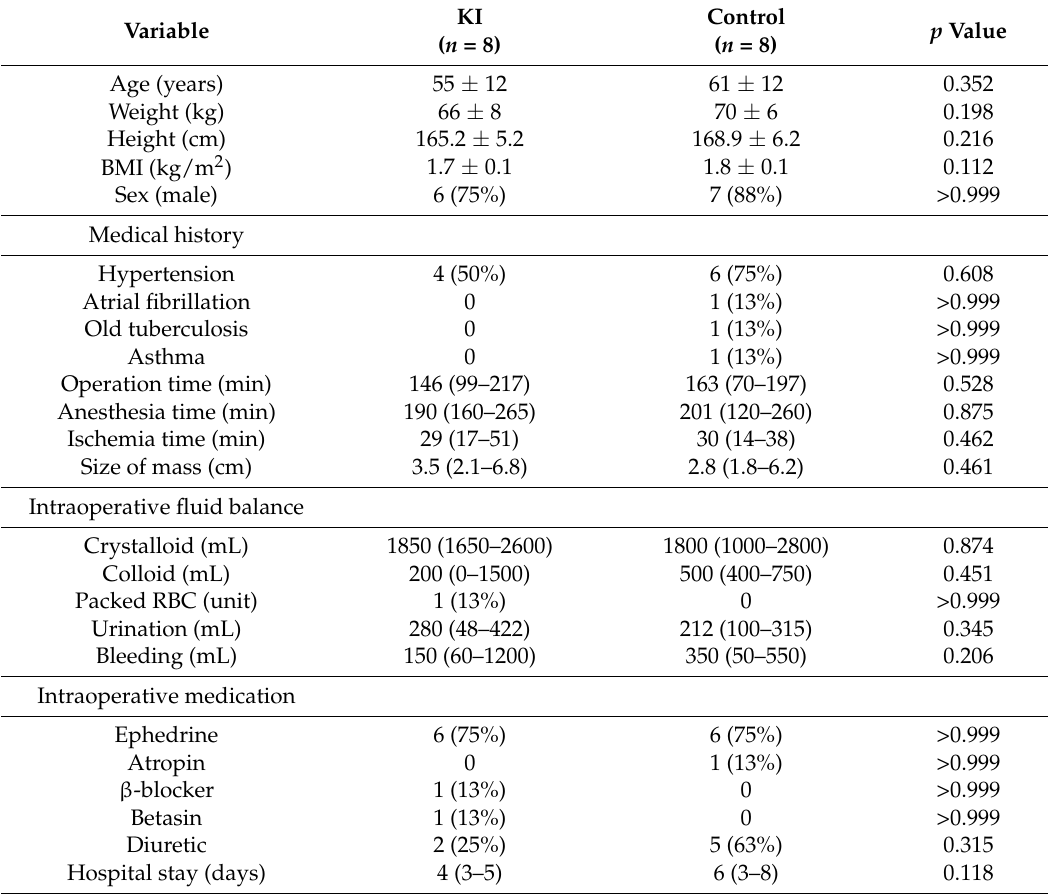
Table 1. Patient characteristics and perioperative